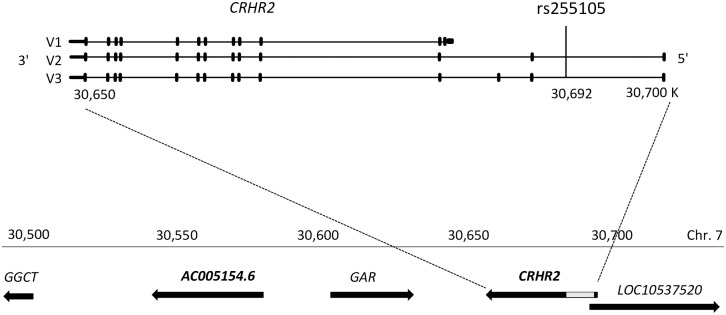
Genomic context of SNP CRHR2 SNP rs255015.The genomic region spanning the AC005154.6 and CRHR2 genes. The main CRHR2 transcripts (V1-V3) are shown.